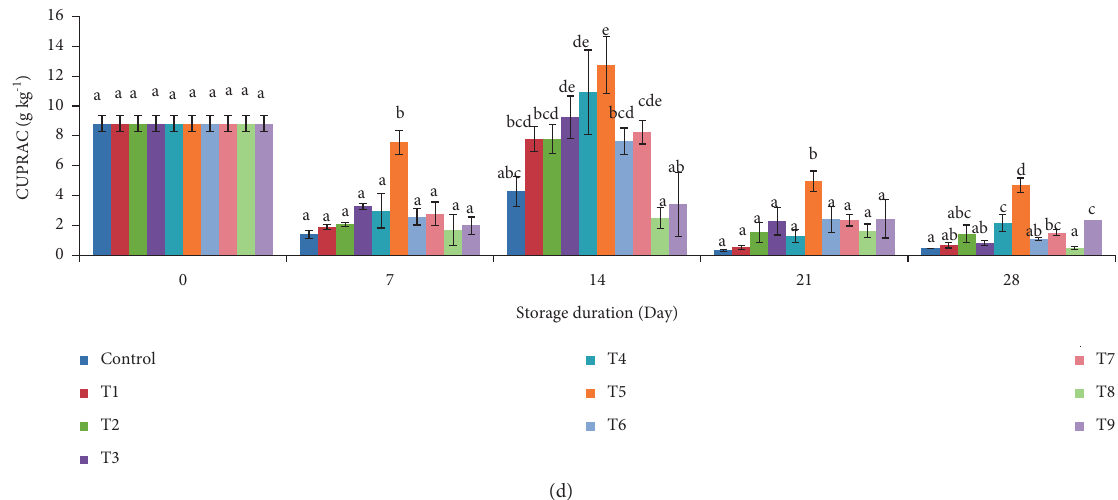
Figure 4: (a) Total phenolic content (TPC), (b) total flavonoid content (TFC), (c) 2,2-diphenyl-1-picrylhydrazyl (DPPH), and (d) cupric reducing antioxidant power (CUPRAC) of pulp of mango cv. “Dashehari” treated with melatonin (MT), followed by low-temperature storage at 5 ± 1 ° C. Measurements were taken every 7d of storage, followed by a 3 d of shelf life at room temperature. Each value is the mean of three replicates; vertical bars indicate the standard error. Different lowercase letters on the same storage period indicate a significant difference ( p < 0 . 05) according to Duncan’s multiple range test. The abbreviated treatment details: 0 (control), 50 µ M for 90min (T1), 50 µ M for 120min (T2), 50 µ M for 150min (T3), 100 µ M for 90min (T4), 100 µ M for 120min (T5), 100 µ M for 150min (T6), 150 µ M for 90min (T7), 150 µ M for 120min (T8), and 150 µ M for 150 min